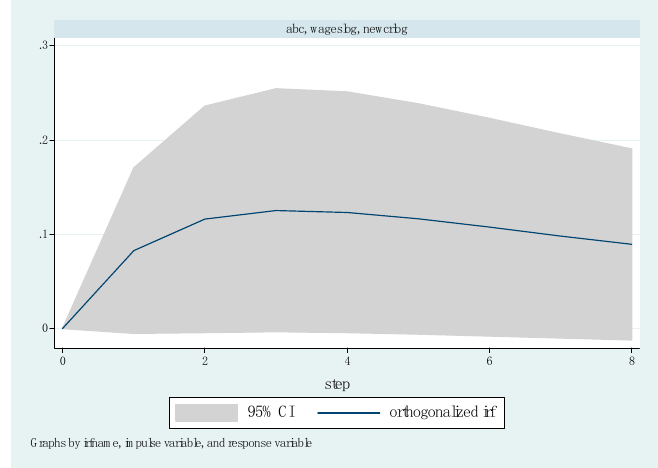
Figure 9. Impulse in the form of a logarithm of salaries growth and a response in the form of a logarithm of new loans growth.